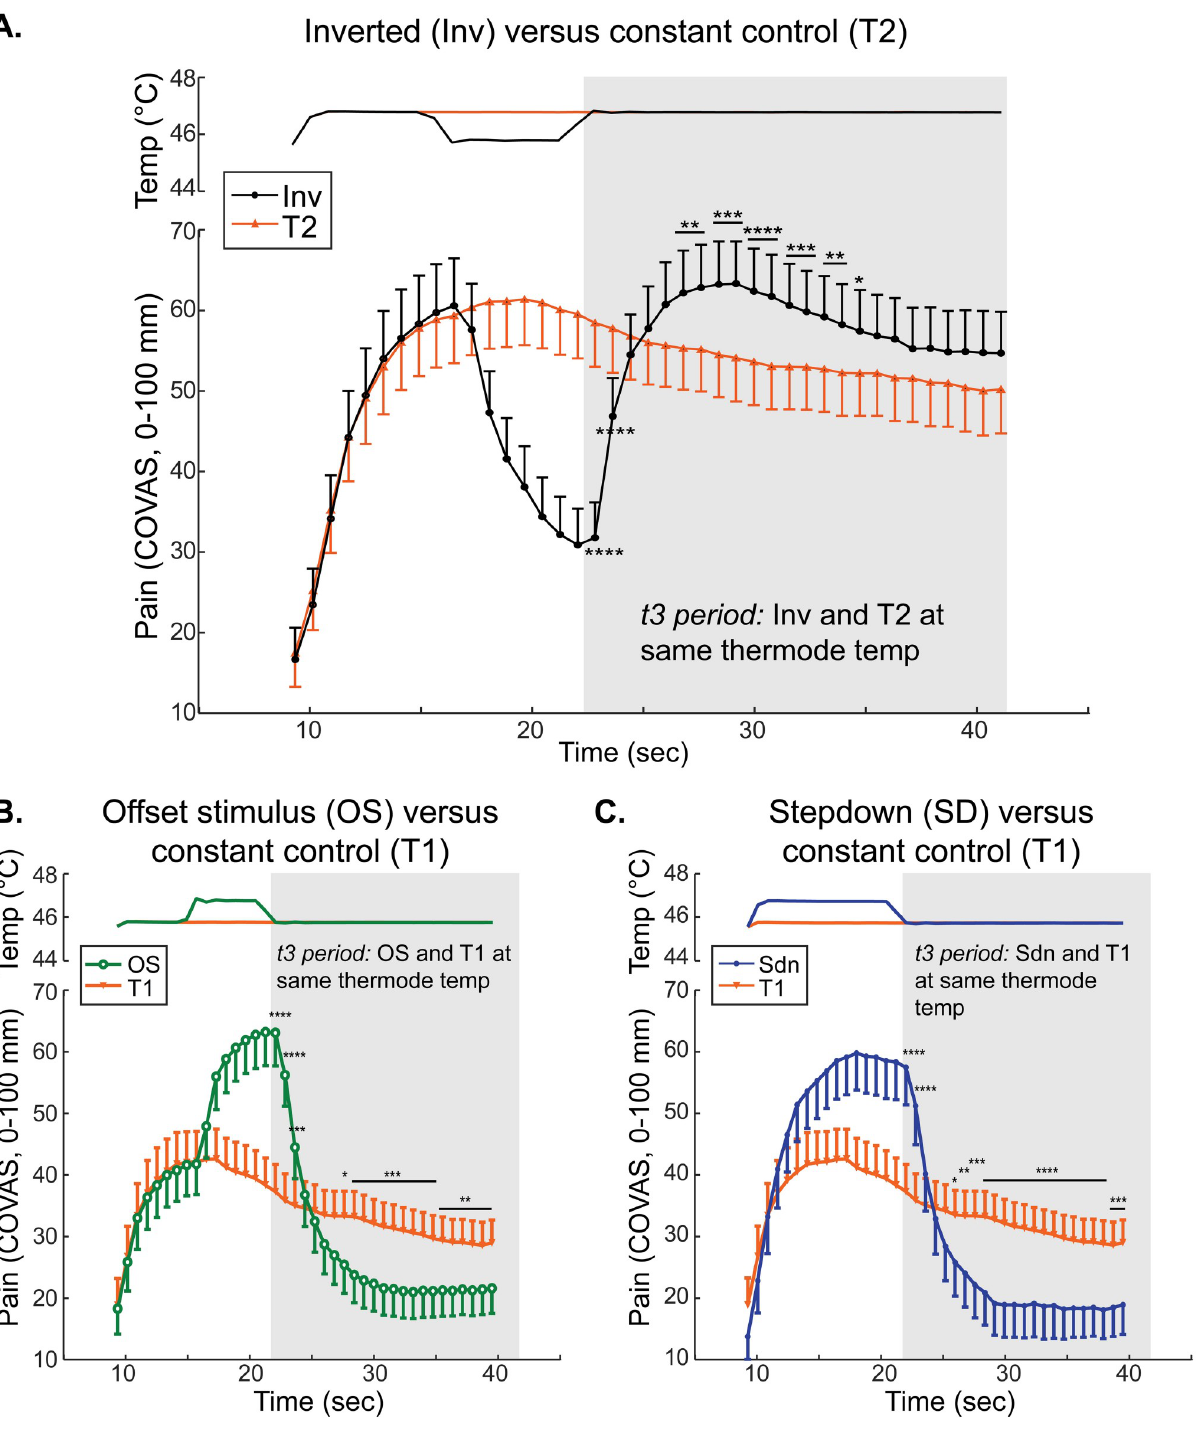
Fig 2. Pain intensity disproportionately increases with an increase in noxious-range temperature. A. Group mean temperature (top) and continuous pain intensity rating (bottom) curves from the Inverted (Inv, black circles) and T2 constant control (orange triangles) stimuli are shown. B. Group mean temperature (top) and continuous pain intensity rating (bottom) curves from the offset stimulus (OS, green circles) and T1 constant control (orange triangles) stimuli are shown. C. Group mean temperature (top) and continuous pain intensity rating (bottom) curves from the Stepdown (Sdn, blue circles) and T1 control (orange triangles) stimuli are shown. A–C. Symbols represent group-level means and error bars represent 95% confidence intervals. P-values: � p < 0.05, �� p < 0.01, ��� p < 0.001, ���� p < 0.0001.